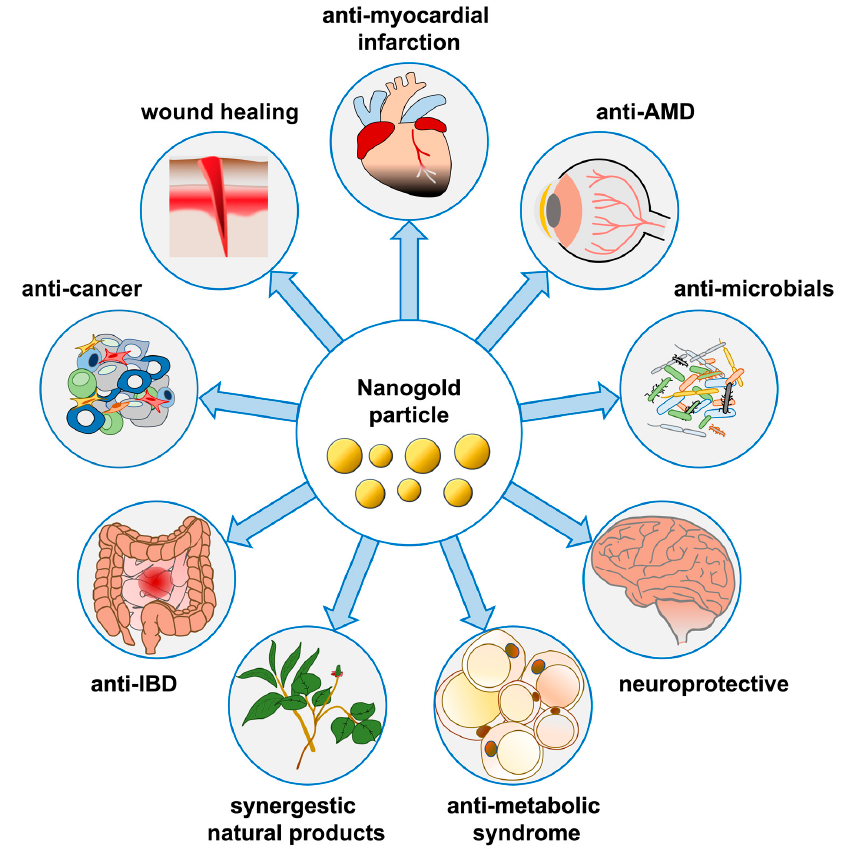
Figure 1. Physiological and pharmacological functions of nanogold in various organ systems and